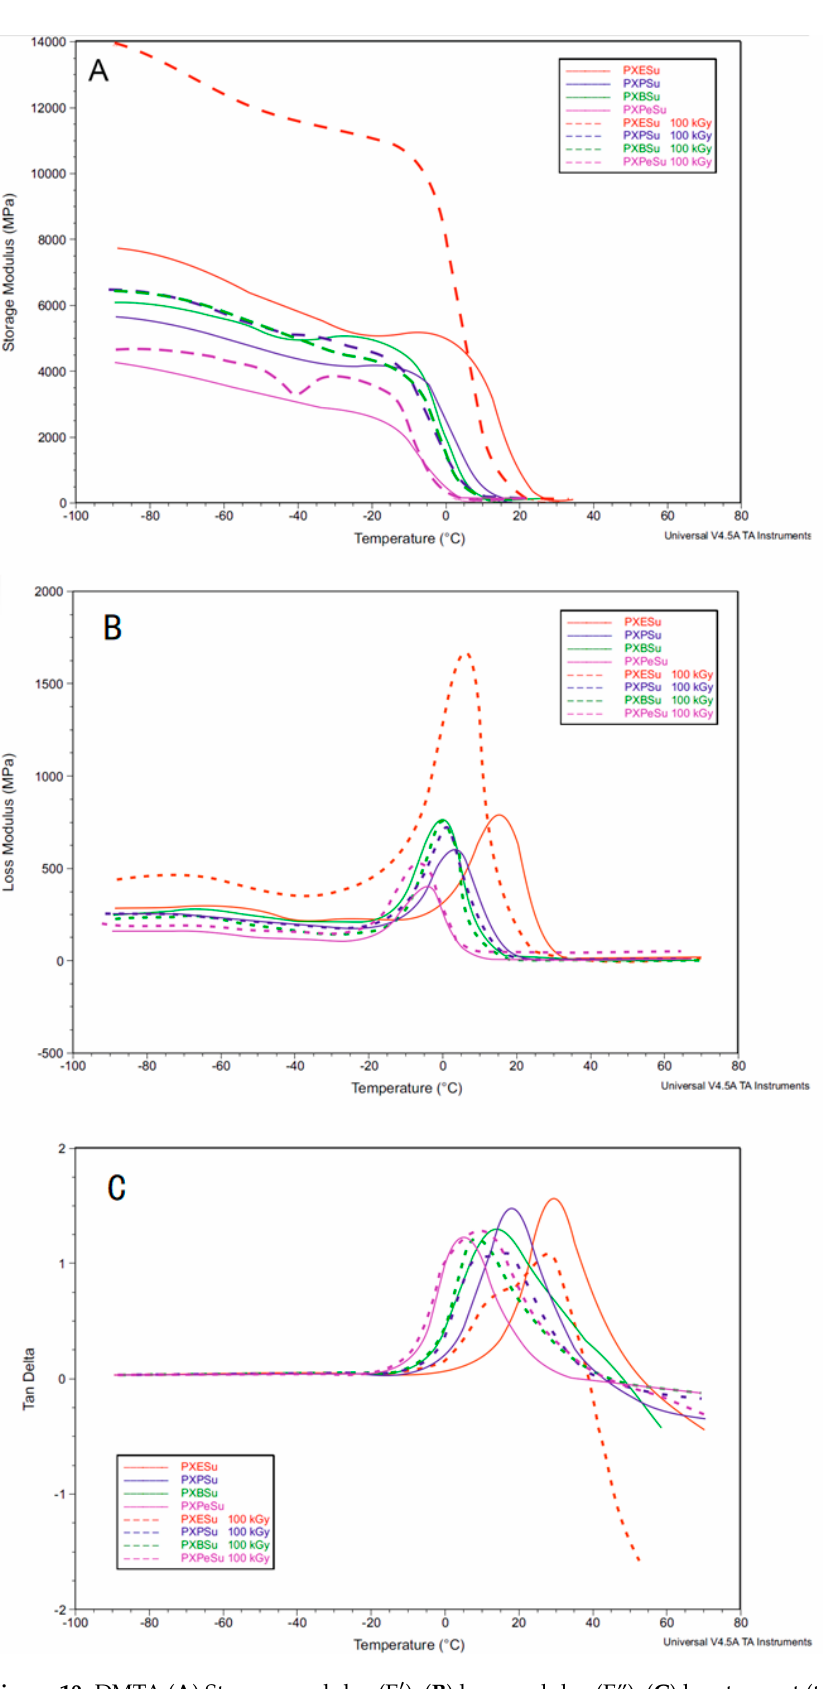
Figure 10. DMTA ( A ) Storage modulus (E’), ( B ) loss modulus (E’’), ( C ) loss tangent (tan delta versus temperature) for PXESu, PXPSu, PXBSu, and PXPeSu.